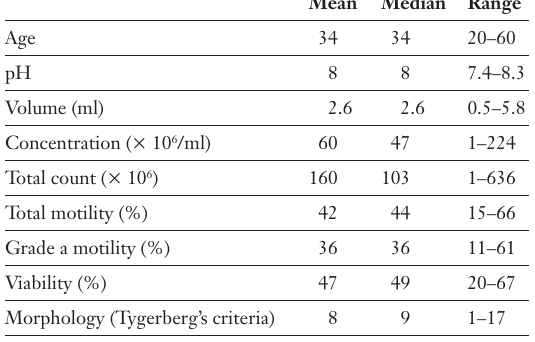
Morphology (Tygerberg’s criteria)